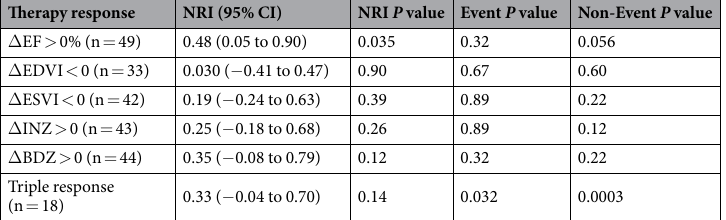
Table 3. Net Reclassification Index (NRI) Analysis for PLS Selected Biomarkers in SC Treated